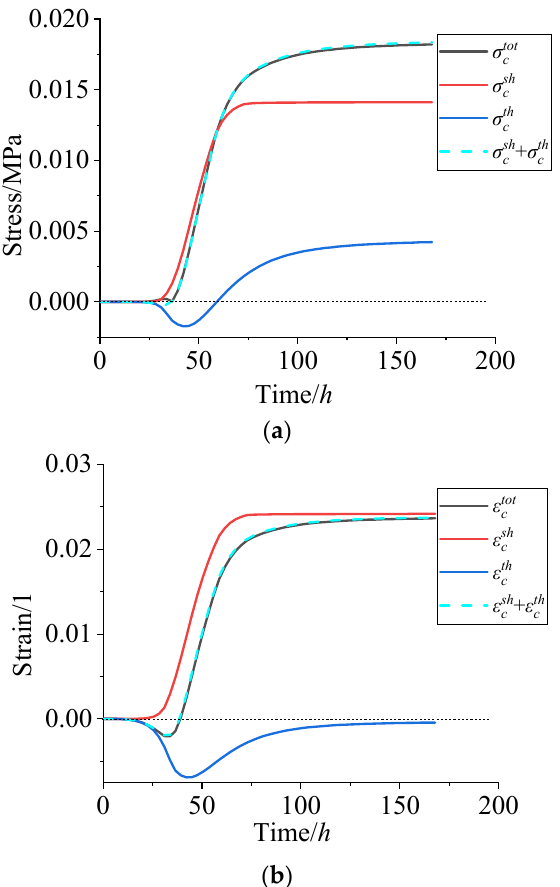
Figure 12. ( a ) Stress vs. curing time. ( b ) Strain vs. curing time.